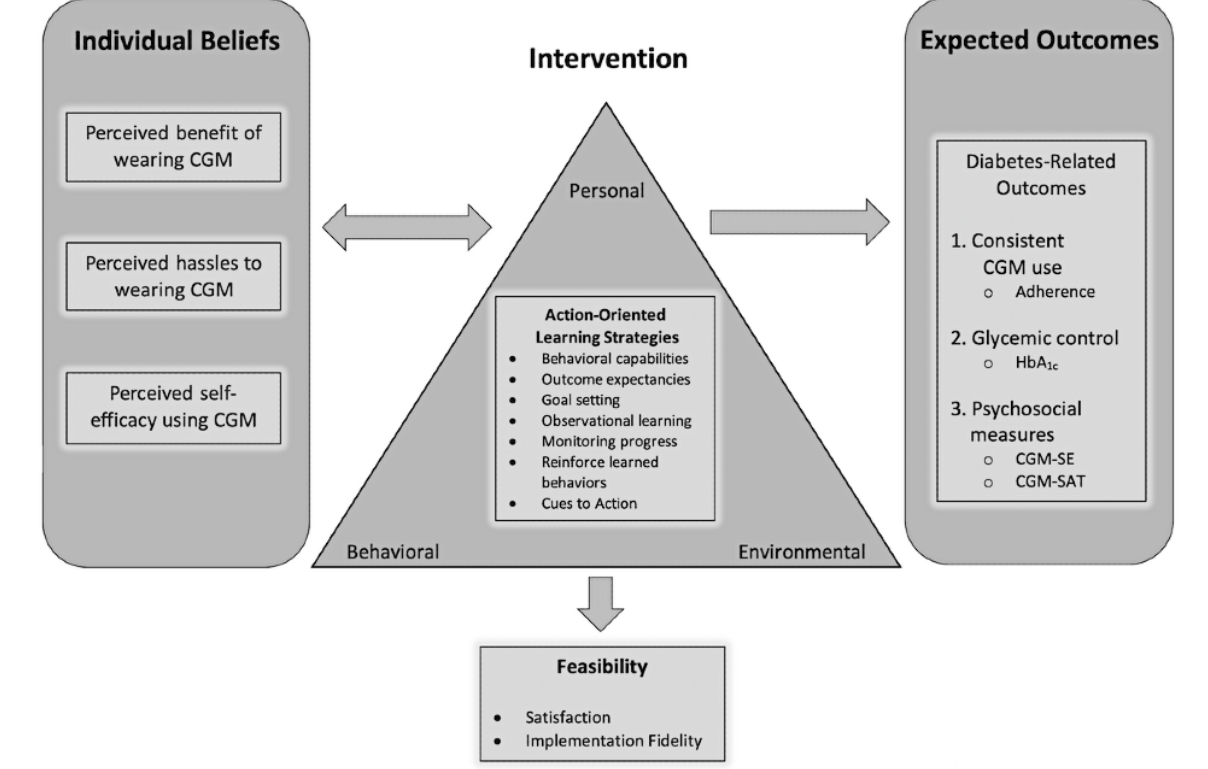
Figure 1. A conceptual model to support the design of the intervention and determined outcome measures. CGM: continuous glucose monitor; HbA 1c :